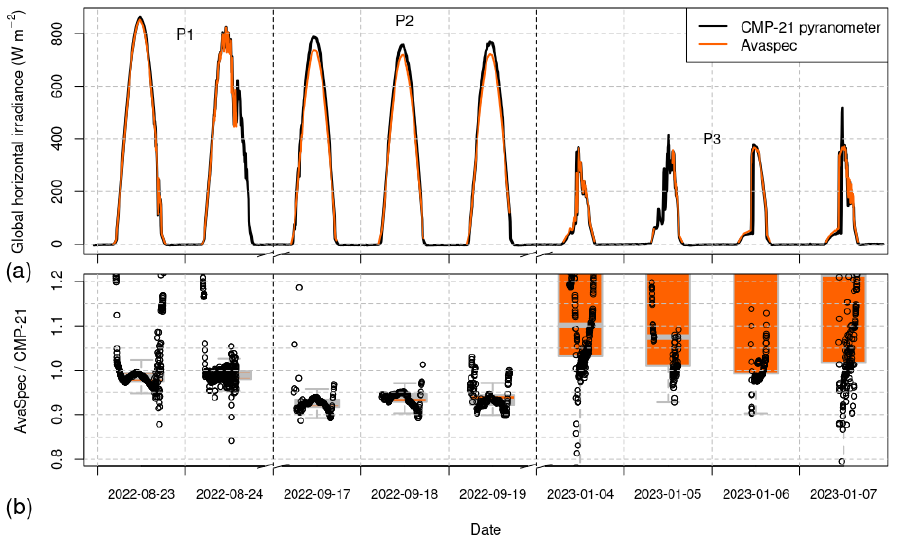
Figure 12. ( a ) Global horizontal integrated irradiance measured by the CMP-21 pyranometer (refer- ence) and the AvaSpec (after compensation for the missing part of the spectrum) during the three intensive periods. ( b ) Ratio of the global horizontal irradiance measured by the AvaSpec and the CMP-21. Notice that data in P2 use the outdated calibration from P1. The coloured area of the boxplots in the background indicates the interquartile distance (25–75%), while the baffles represent the whole range of the data (circles) with the exception of the